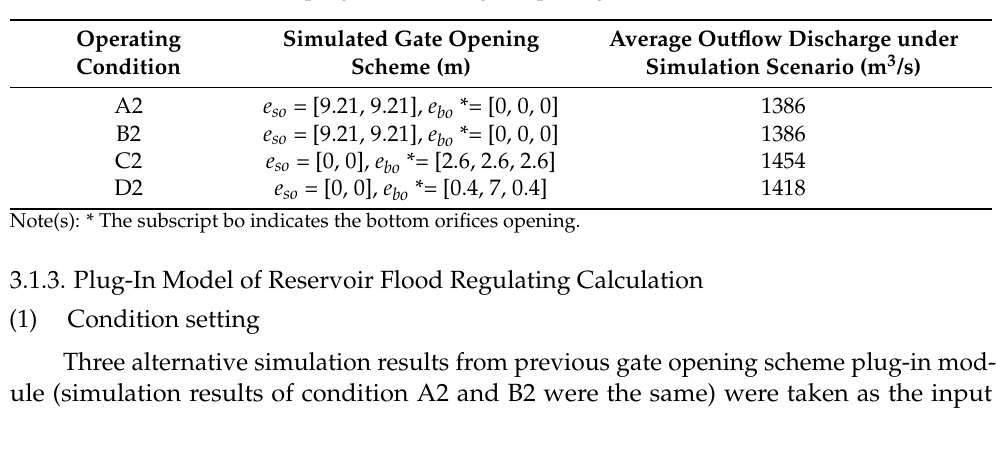
Table 9. Simulation results of plug-in model of gate opening scheme in Wudu